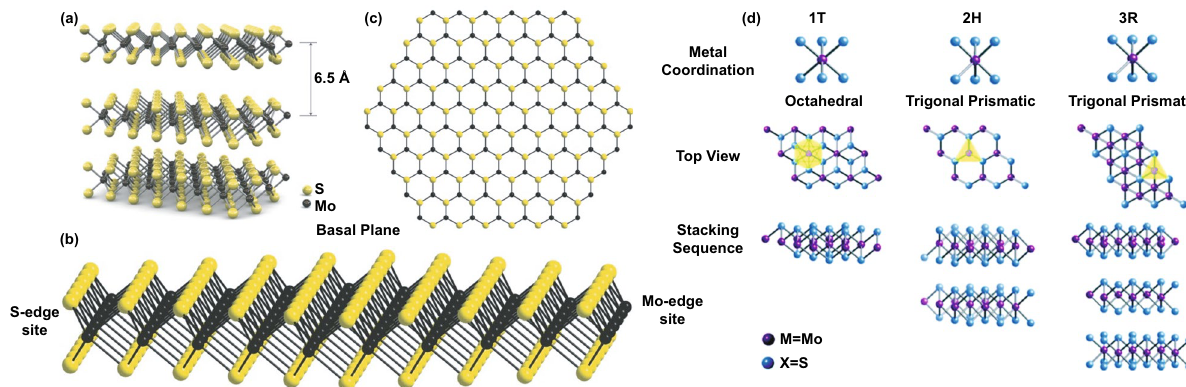
Fig. 9 a 3D form of bulk MoS 2 and b, c side and top views of 2D hexagonal layouts of single-layer MoS 2 (H ‐ MoS 2 ). Reprinted with permission from Ref. [154]. Copyright 2011, Nature Publishing group. d Metal coordination and stacking sequences of TMD structural unit cells. Metal coordination can be either octahedral or trigonal prismatic. The octahedral coordination allows stacking sequences, which yield a tetragonal symmetry (1 T). Dissimilar stacking sequences of trigonal prismatic single layers give rise to different symmetries, including hexagonal sym- metry (2H) and rhombohedral symmetry (3R). Reproduced with permission from Ref. [148]. Copyright 2017, The Royal Society of